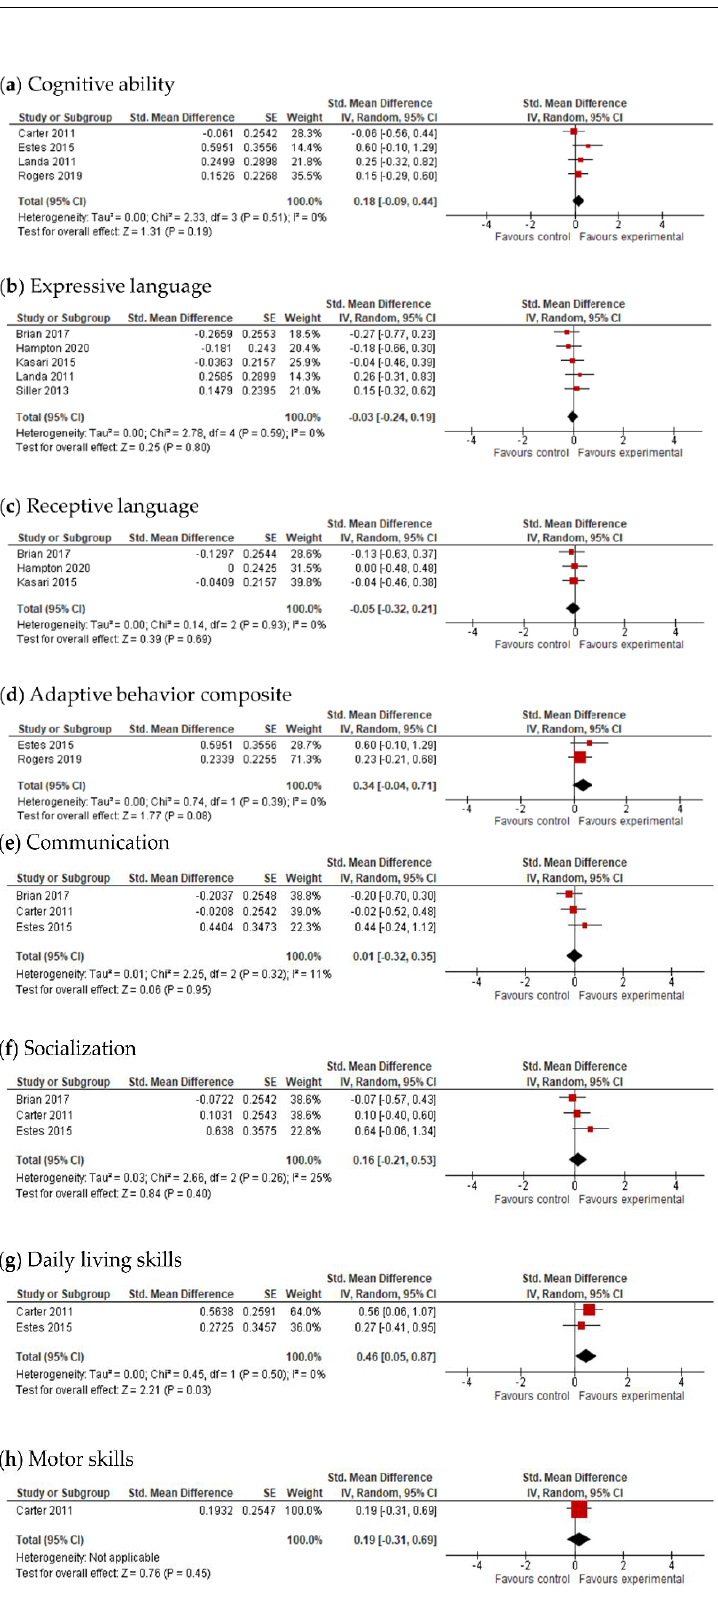
Figure 11. Forest plots for follow-up data. ( a ) Cognitive ability [29,33,41,49]. ( b ) Expressive language [28,37,40,41,52]. ( c ) Receptive language [28,37,40]. ( d ) Adaptive behavior composite [33,49]. ( e ) Communication [28,29,33]. ( f ) Socialization [28,29,33]. ( g ) Daily living skills [29,33]. ( h ) Motor skills [29].